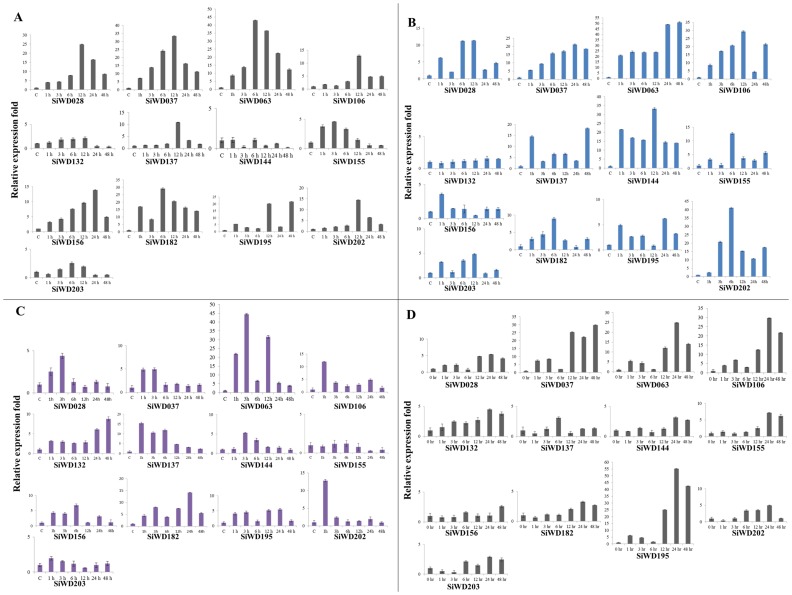
The relative expression ratio of 13 candidate SiWD40 genes analyzed using qRT-PCR under (A) dehydration stress, (B) salinity stress, (C) ABA treatment (D) Cold stress for 0, 1, 3, 6, 12, 24 and 48 h.The relative expression ratio of each gene was calculated relative to its expression in control sample (0 h). Act2 was used as an internal control to normalize the data. The error bars representing standard deviation were calculated based on three technical replicates for each biological duplicates.